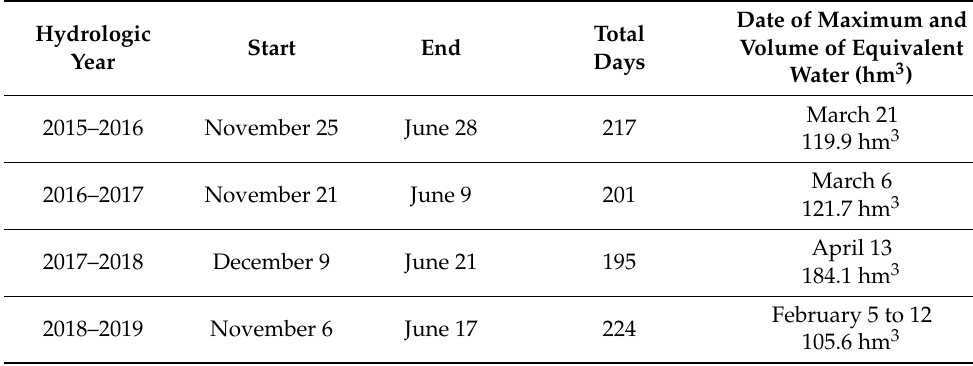
Table 2. Start and end dates of uninterrupted volumes of more than 10 hm 3 of snow (equivalent water volume) in the upper G á llego River basin (up to the B ú bal Reservoir), by hydrological years 2015/2016 to 2021/2022. It includes number of days for each hydrological year, value and date of maximum accumulation. Data source and methodology: CHE-SAIH [49,51,52].